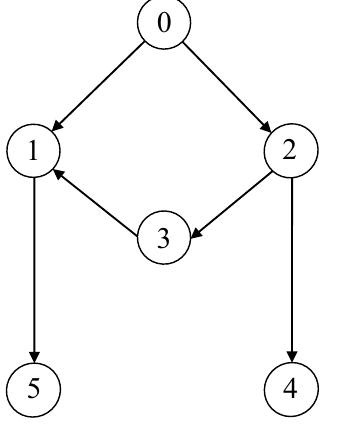
Figure 2. Communication network in the